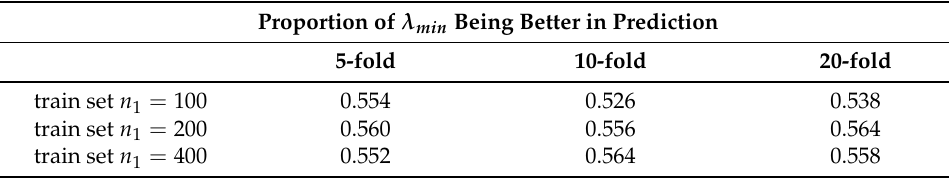
Table 2. Regression estimation (cross validation): Boston Housing Price.